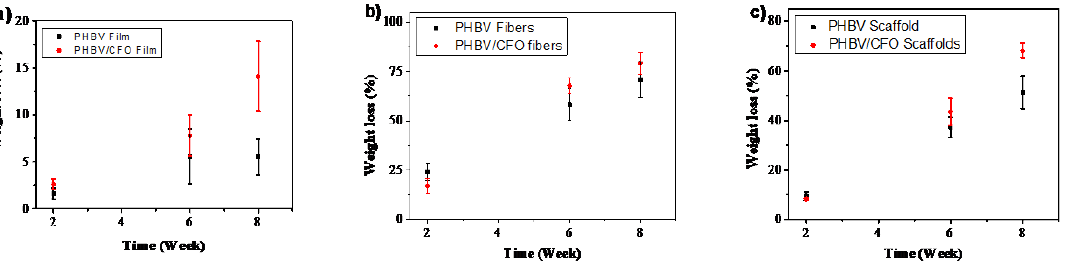
Figure 7. Weight loss relative to the original mass after degradation for 2, 6 and 8 weeks in SBF for ( a ) PHBV and PHBV / CFO films, ( b ) fibers and ( c ) scaffolds.